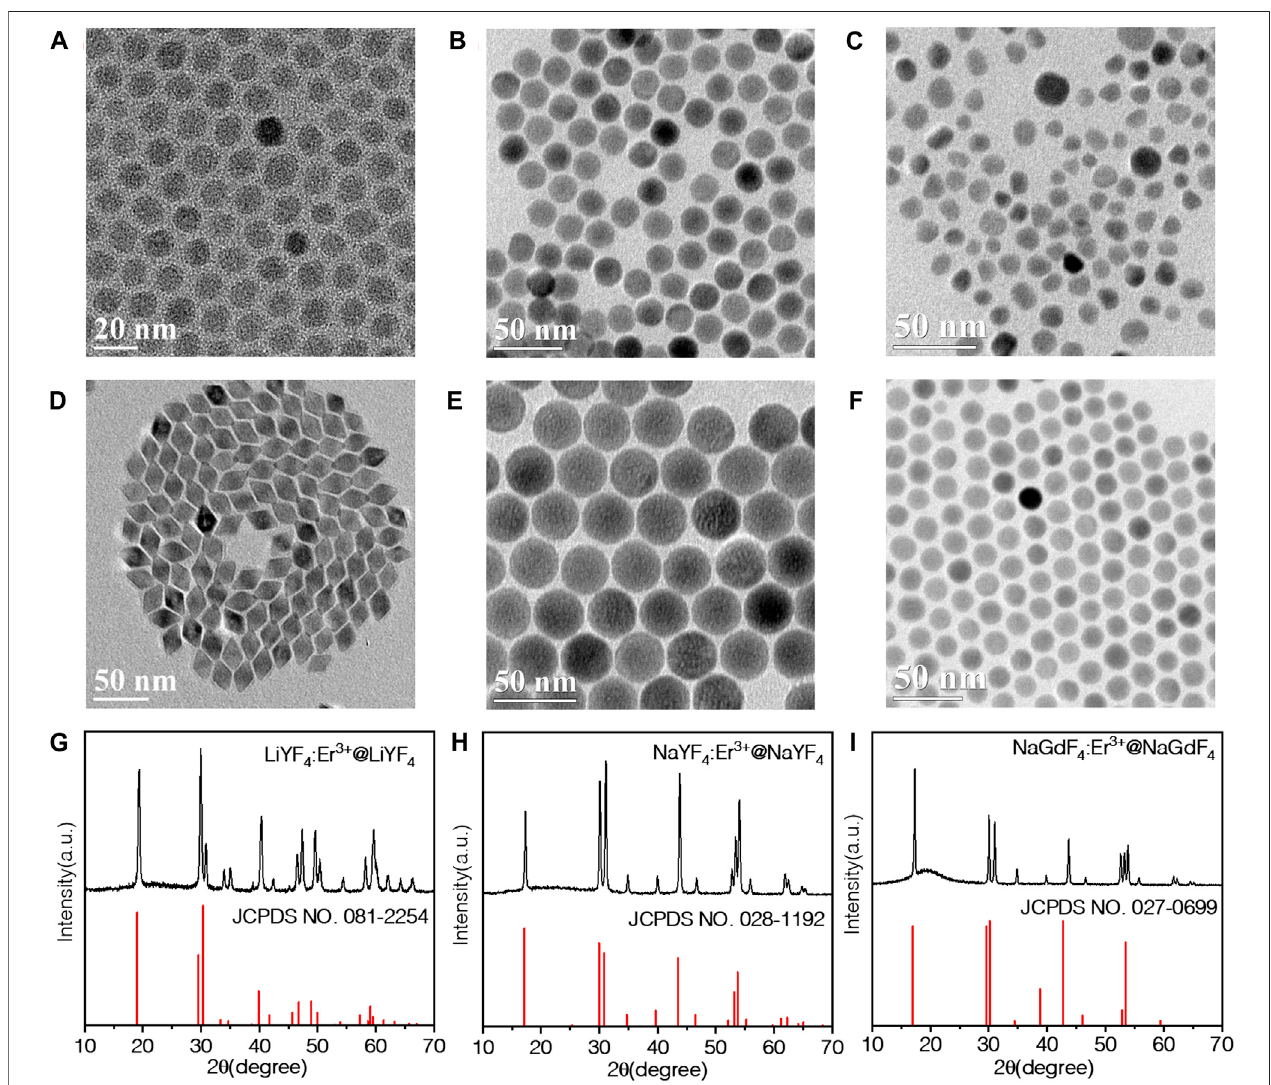
FIGURE 1 | TEM images of (A) LiYF 10%Er 3+ @NaGdF 4 nanoparticles; and XRD pattern of (G) LiYF 4 :10%Er 3+ @LiYF 4 , (H) NaYF 4 :10%Er 3+ @NaYF 4 , (I) NaGdF 4 :10%Er 3+ @NaGdF 4